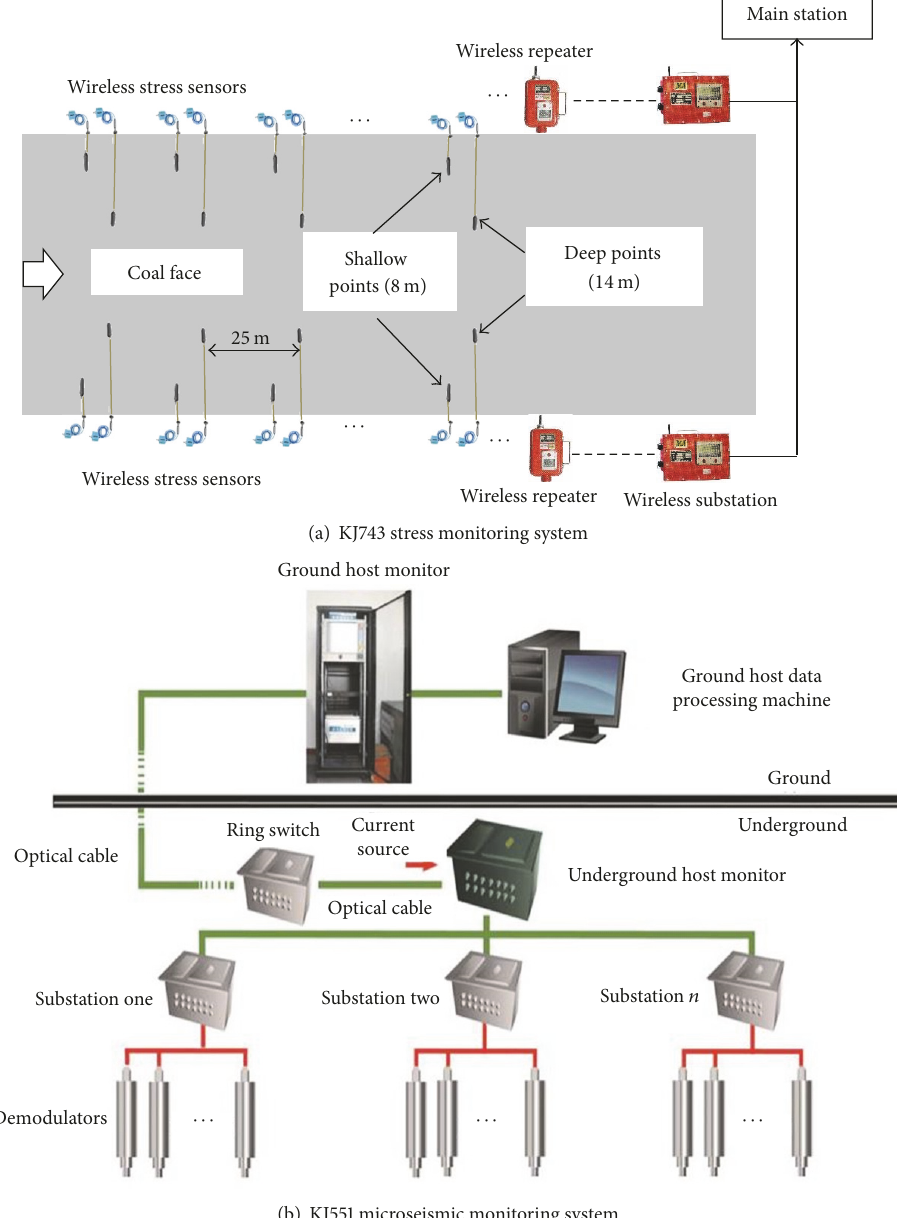
Figure 6: Monitoring systems and